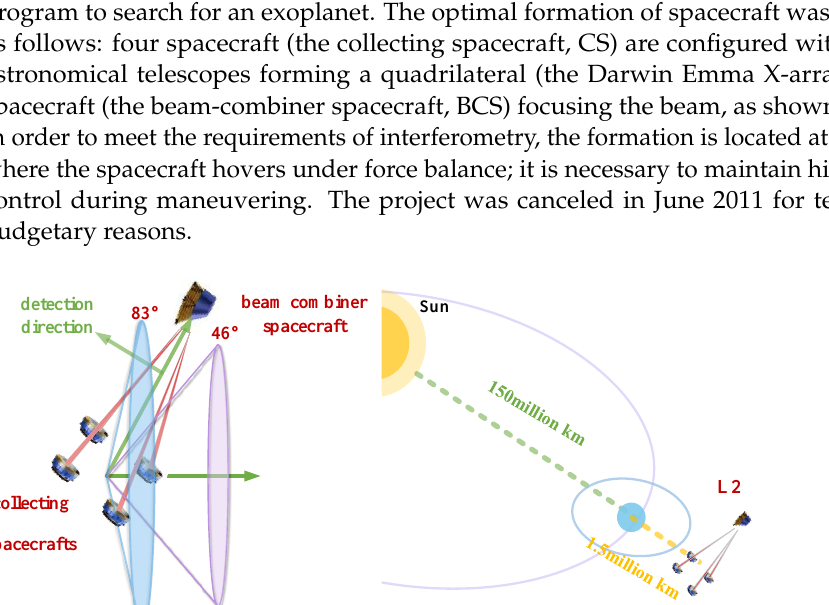
Figure 2. Diagram of the Darwin project. ( a ) Formation shape of Darwin, ( b ) Space orbit schematic of Darwin.